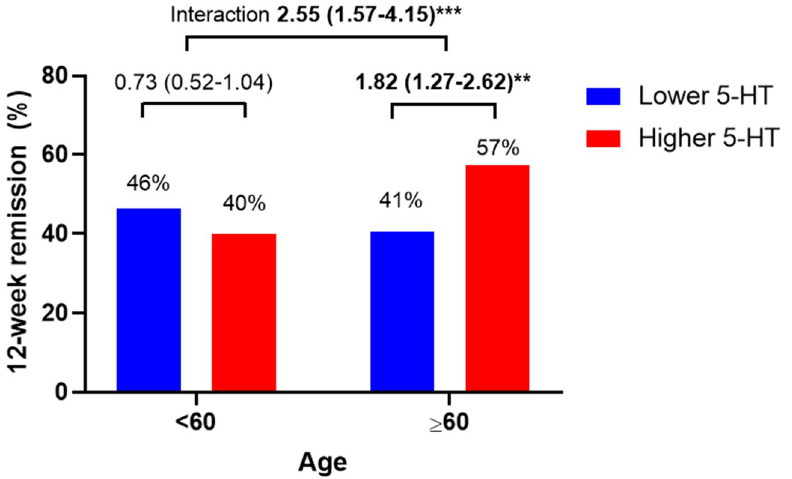
Figure 2. The 12-week remission rates according to baseline serum 5-HT level and age. Data are presented as odds ratios (95% confidence intervals) adjusted for educational level, living alone, religious observance, melancholic features, atypical features, age at onset, duration of present episode, HAMD score, HADS-A score, and SOFAS score. **P < 0.01; *** P <